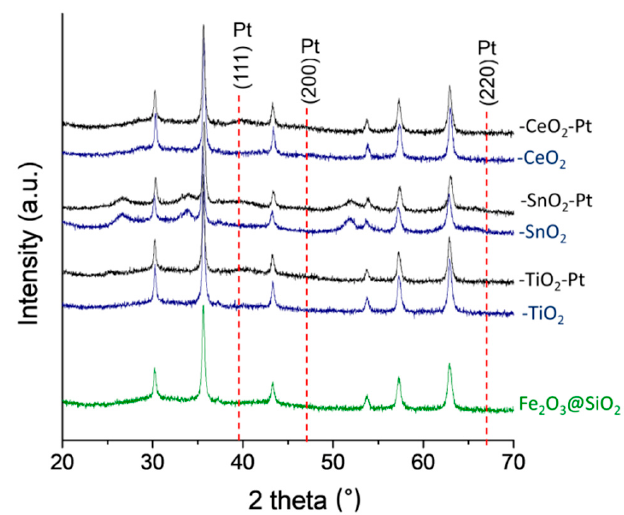
Figure 3. XRD patterns of Pt and non-Pt content of Fe 2 O 3 –SiO 2 –MeO 2 (Me = Ti, Sn, Ce) materials.